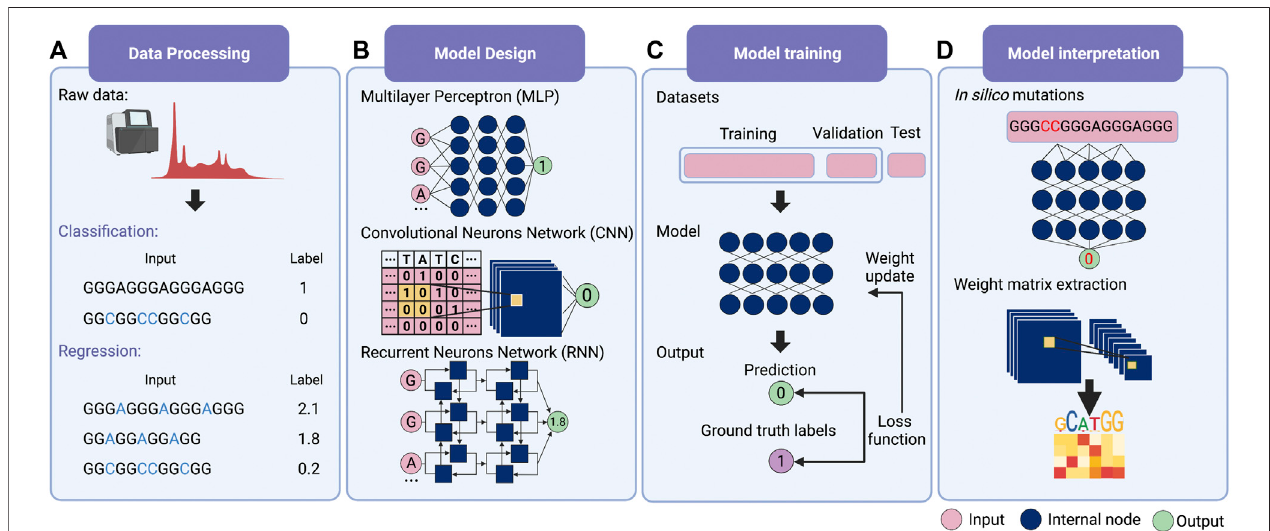
FIGURE1| Schematicoverviewofdeeplearningwork fl ow. (A) Dataprocessing.Supervisedlearningrequiresexplicitlabellingofthedata,includingclassnumbers in classi fi cation questions and values in regression questions. (B) Model design. Multilayer perceptron (MLP), convolutional neural network (CNN) and recurrent neural network (RNN) are the three main families of deep learning architecture. Typically, deep learning models assemble different architectures based on data structures. (C) Modeltraining.Thetotaltrainingdatais fi rstdividedintothetrainingset,thevalidationsetandthetestset.Thentheinputdataispassedintothemodeltoobtainthe predicted values. The loss function is applied to evaluate the difference between the predicted and the true values, whereby the model weights are updated. (D) Model interpretation. Features ’ importance canbe obtained by insilico mutations. Forthe CNN model, the features canalso be evaluated byextracting theweight matrix ofthe fi